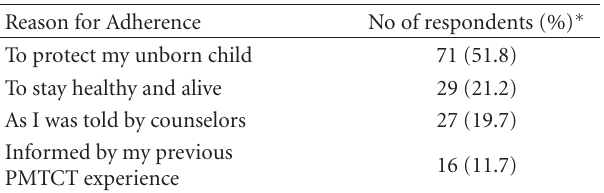
Table 3: Reason for adherence to ARV drugs among respondents with over 95% drug adherence.